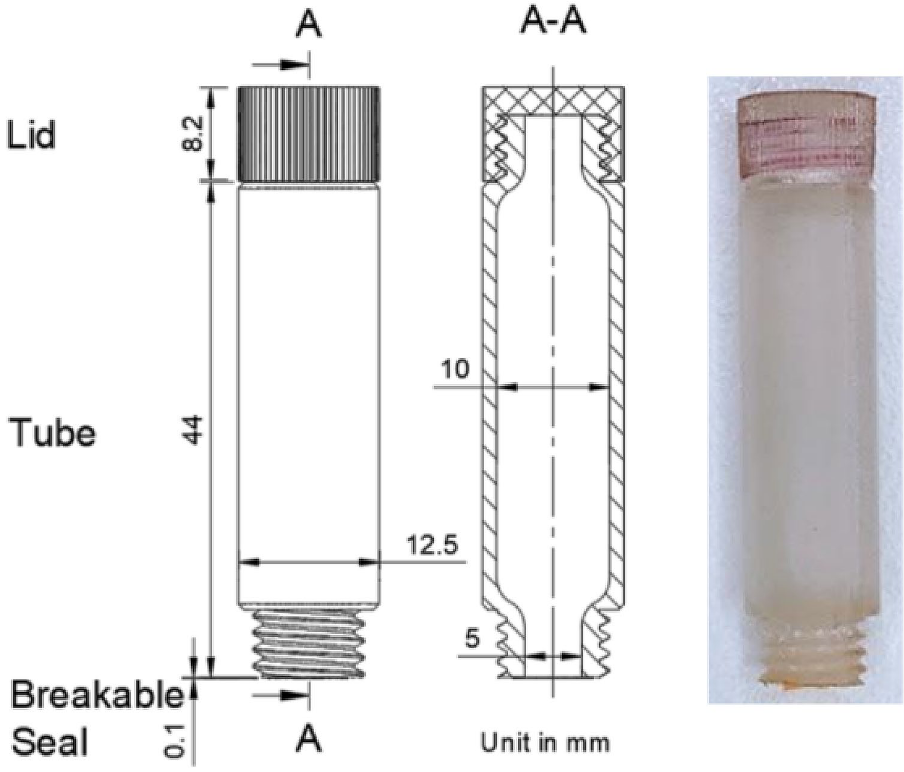
Figure 3. Design drawing and photograph of the sample collection tube. Two openings at different ends of the tube, one end for sample entering and the other connects to the